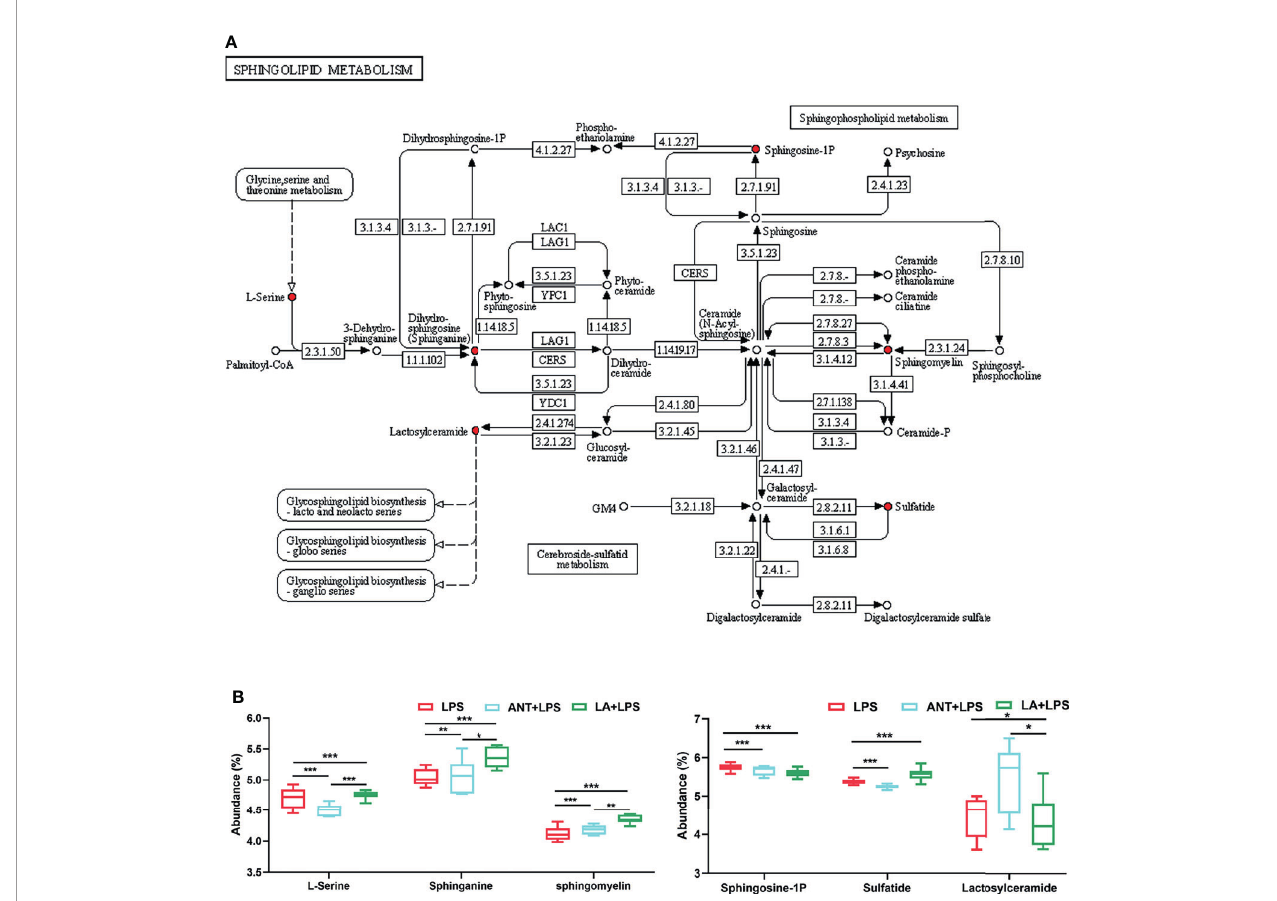
FIGURE 4 | Analysis of Sphingolipid metabolism pathway. LPS: fed with a basal diet and injected with 0.5 mg/kg LPS; ANT+LPS: fed with a basal diet supplemented with 75 mg/kg ANT, and injected with 0.5 mg/kg LPS; LA+LPS: fed with a basal diet supplemented with 1000 mg/kg LA, and injected with 0.5 mg/ kg LPS. N=6 in each group. (A) Kyoto Encyclopedia of Genes and Genomes (KEGG) pathway map of Sphingolipid metabolism (map00600). The red nodes represent the differential metabolites. (B) Analysis of the differential metabolites by one-way ANOVA and Tukey ’ s test. * P < 0.05, ** P < 0.01, *** P <